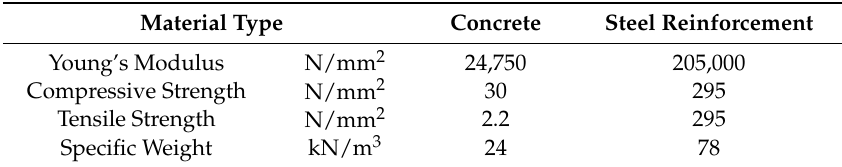
Table 1. Material properties of the slab for analysis.